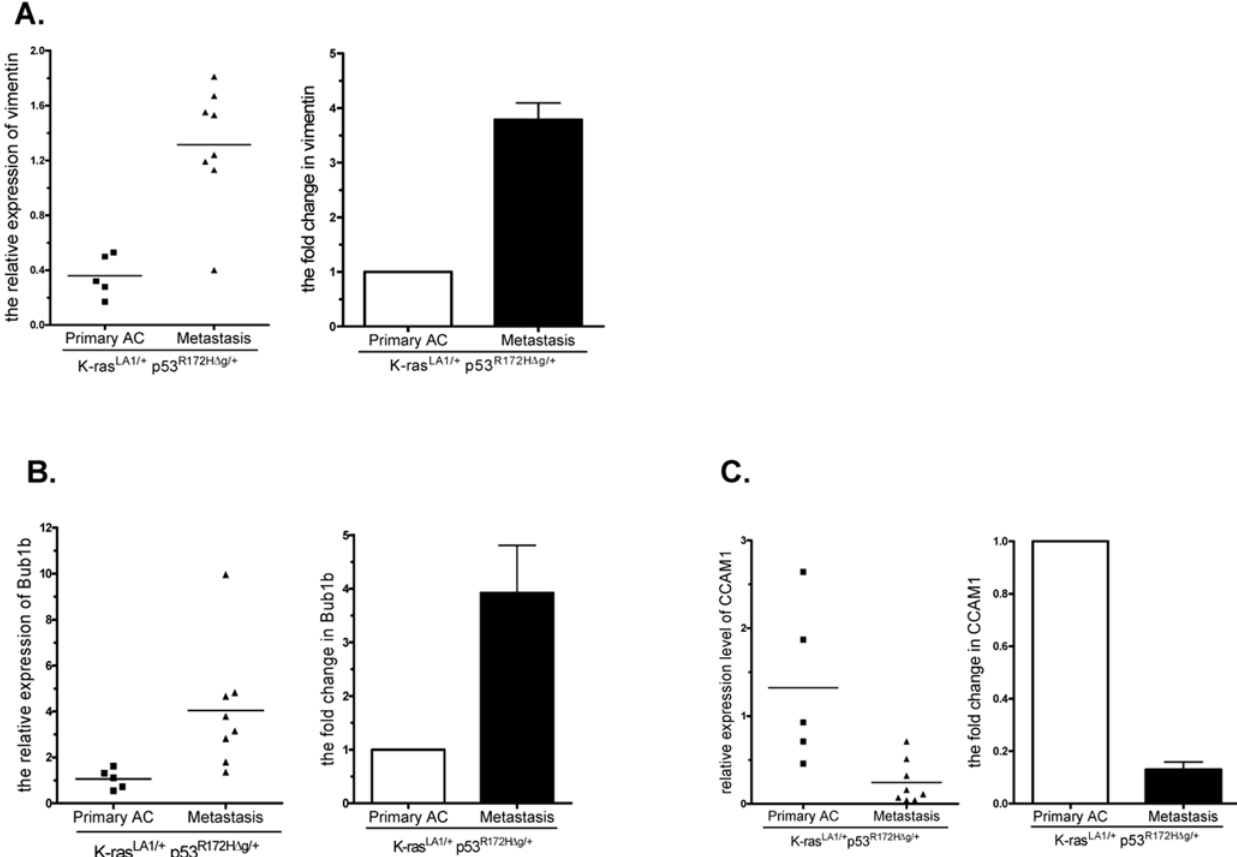
Figure 2. Verification of mRNA expression levels by Q-PCR. Total RNA from spontaneous tumors for gene expression profiling was reverse- transcribed with the First-Strand cDNA Synthesis Kit (Amersham Bioscience). Real-time PCR reactions were prepared in duplicate in a 96- or 384-well clear optical reaction plate (Applied Biosystems), using SybrGreen master mix (Applied Biosystems), and run on an ABI PRISM 7900HT Sequence Detection System (Applied Biosystems). Normal lung tissue from wild-type mice was used for calibration. Glyceraldhyde-3-phosphate dehydrogenase (GAPDH) was used as the endogenous control. The relative level of a gene was determined by calculating DD Ct, based on the formula DD Ct=(sample Ct [gene] 2 sample Ct [GAPDH]) 2 (normal lung Ct [gene] 2 normal lung Ct [GAPDH]).